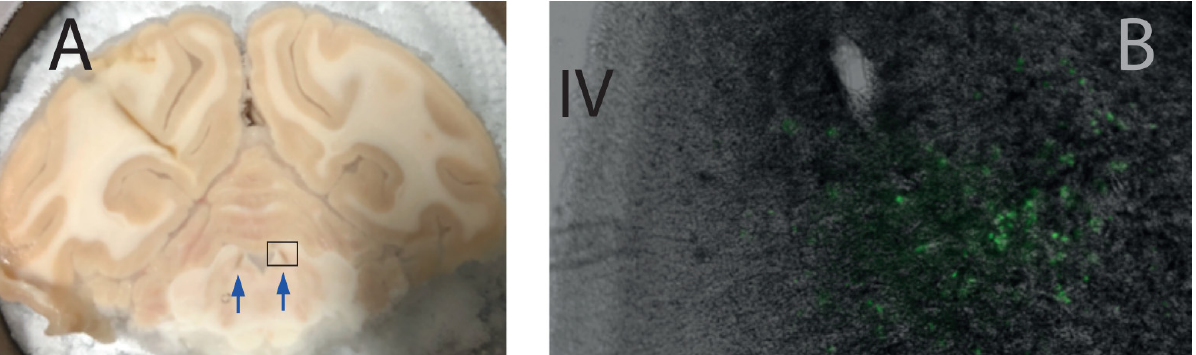
Figure 3. Histological validation of DREADD expression in the LC. Panel ( A ) shows a brain section at the level of the LC (brown nucleus, arrow), which is clearly visible on the side of the IVth ventricle. The rectangle on panel ( A ) shows the approximate location of the section on panel ( B ). ( B ) Photomicrograph of a 40 µm section taken with a fluorescence microscope. The fourth ventricle (IV) is visible on the left side of the picture, and the fluorescence emitted by the reporter protein is clearly visible at the expected location of the LC. Note that we used a green filter to capture the fluorescence of the CFP.